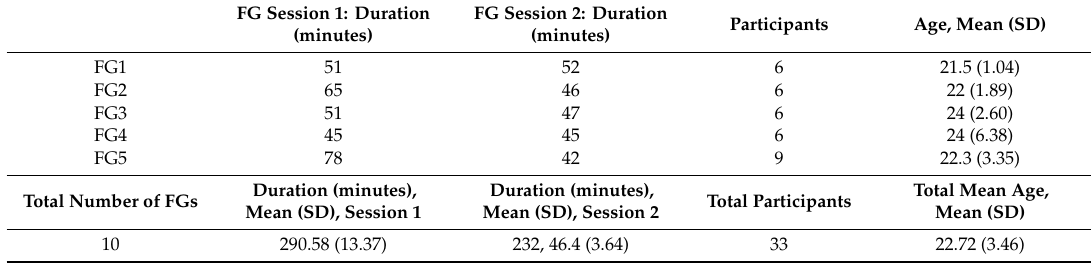
Table 1. Data collection